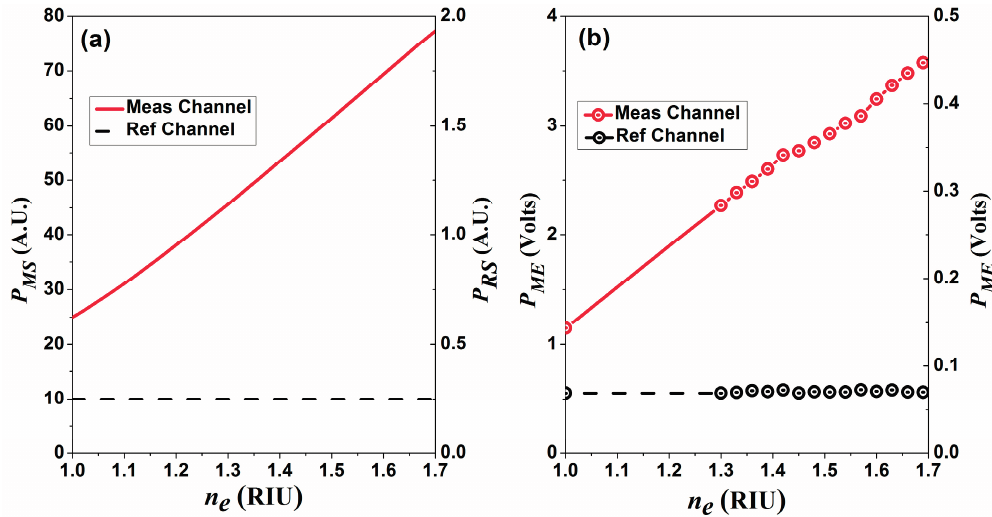
Figure 8. Detector outputs as a function of the exit refractive index, ( a ) simulated results; ( b ) experimental